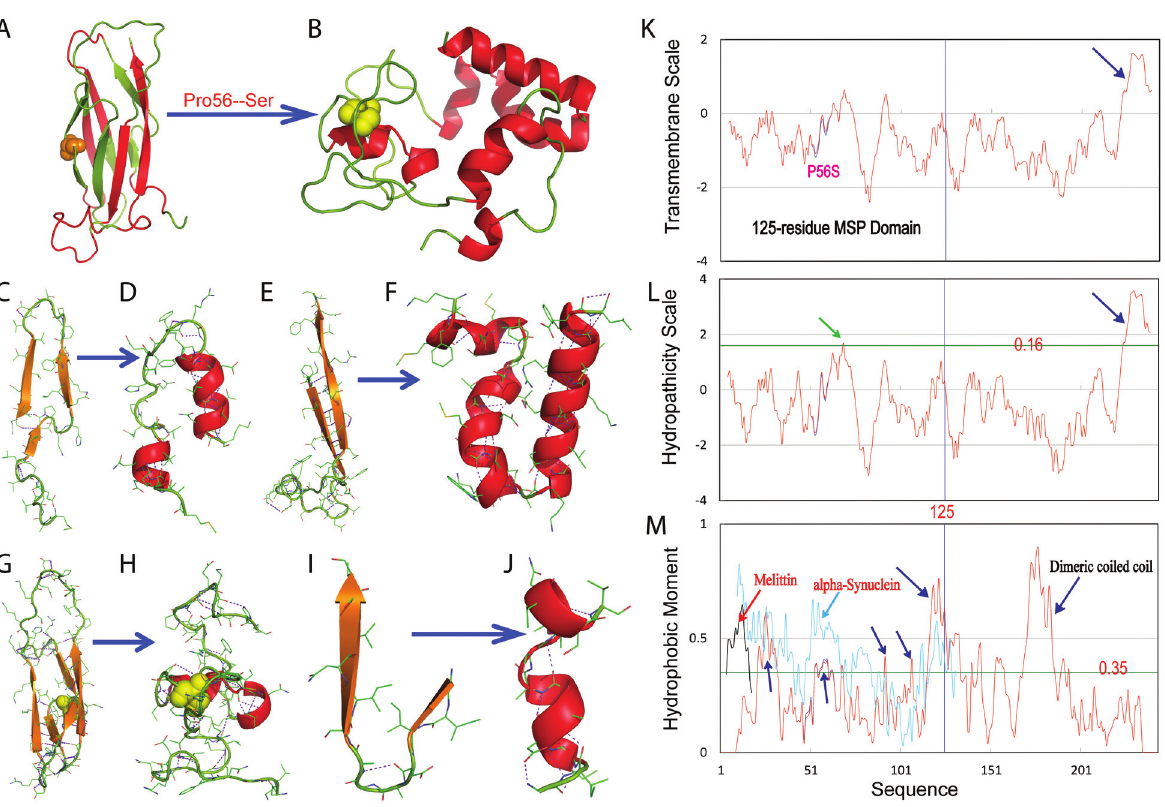
Figure 5. Chameleon transformation from the all- β cytosolic fold into a membrane-embedded helical protein. A – B . Chameleon transformation from a seven-stranded immunoglobulin-like β -sandwich fold to a membrane-embedded helical structure. C – J . Secondary structures of different regions adopted in the wild-type and membrane-embedded P56S MSP respectively. K . Transmembrane scale of the full-length wild-type (blue) and P56S (red) VAPB (243 residues) calculated with the previous method 56 . L . Hydrophobicity scale calculated with the previous method 55 . M . Hydrophobic moment of the full-length wild-type (blue) and P56S (red) VAPB (243 residues) calculated with the previous method 57 . Hydrophobic moment of the honeybee membrane toxin mellitin is colored in black and that for α -synuclein in